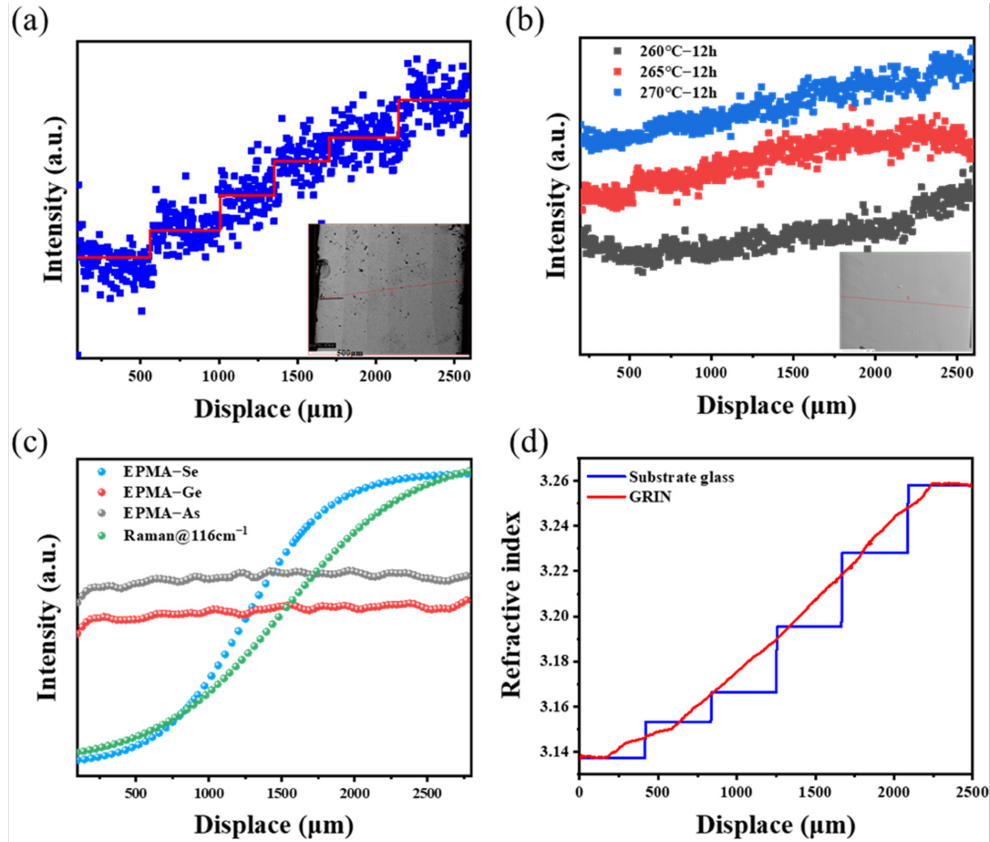
Figure 7. EPMA line scanning results of the two GRIN samples. ( a ) The element distribution of 20 min thermal diffusion (blue dot) and the corresponding refractive index distribution (red line); ( b ) thermal diffusion of 12 h, and it becomes linear with the temperature increase; ( c ) EPMA test of the Ge, As, and Se concentrations with distance and the relationship between Raman peak intensity (116 cm − 1 ) and distance; ( d ) refractive index changes of the cross-section of the GRIN lens (270 ◦ C–12 h) and the refractive index change of the substrate